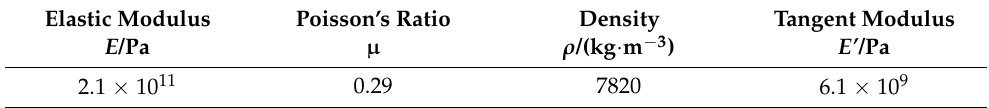
Table 1. Physical parameter of